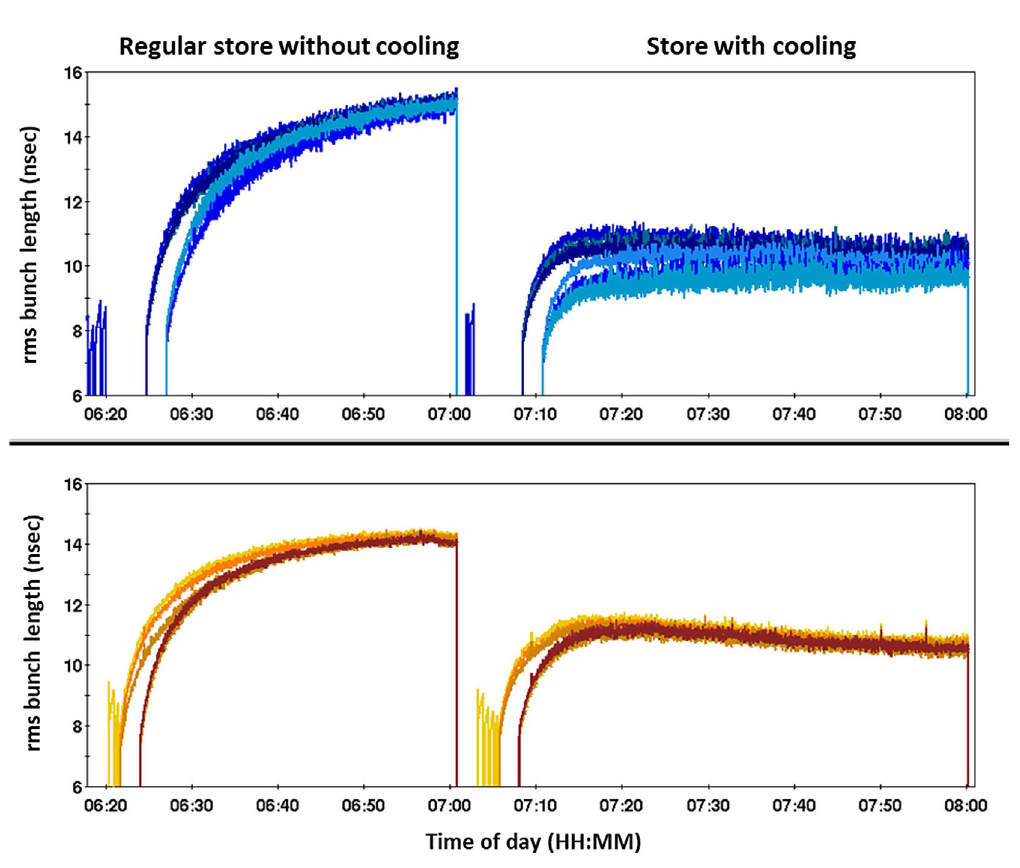
FIG. 14. Bunch length reduction in both RHIC rings as a result of longitudinal electron cooling running in the 9 MHz CW mode. Top: Bunch length of the first three and the last three bunches in the blue ring. Bottom: Bunch length of the first three and the last three bunches in the yellow